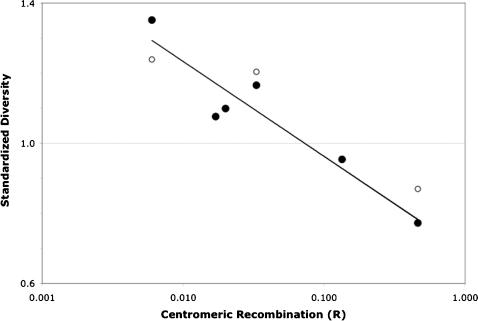
Relationship between mean standardized diversity in northern populations and recombination with the centromere.Filled circles represent mean standardized diversity within the three northern samples (mean HI, IR, SB/FP) plotted in relation to estimated linkage with the centromere on a log scale. A significant (p<0.01) linear relationship is described by the plotted line, y = 0.692−0.271x, fitted on the log transformed recombinant fraction (R). For comparison, unfilled circles are plotted for mean diversity within the three northern samples standardized using a different southern sample [LP from ref. 24].